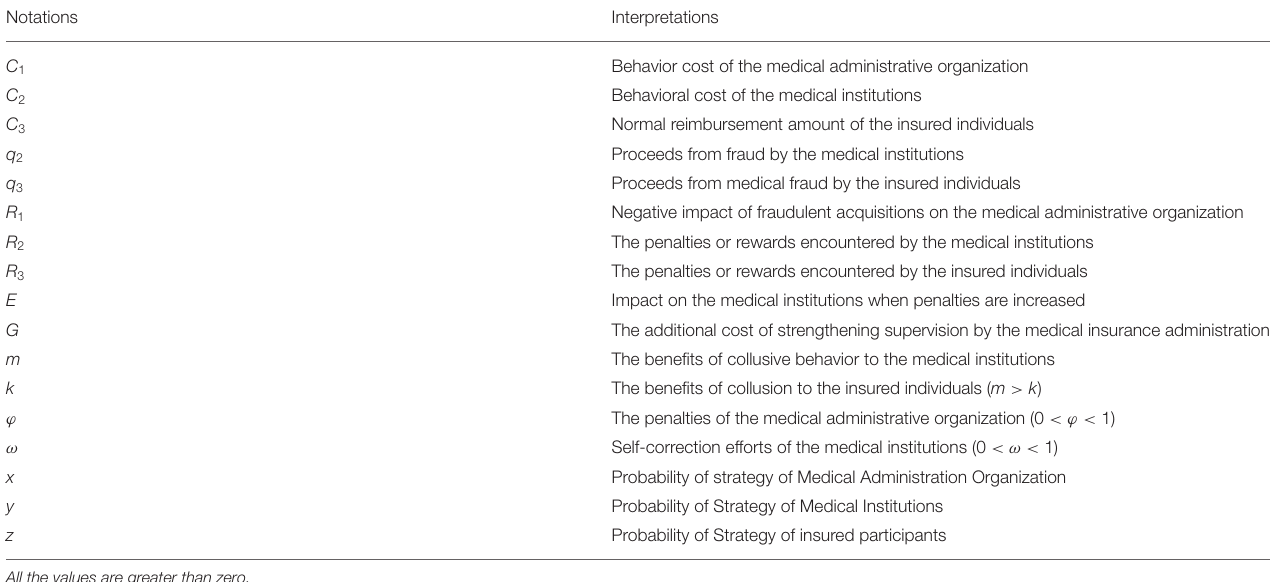
TABLE 1 | Notations and interpretations.